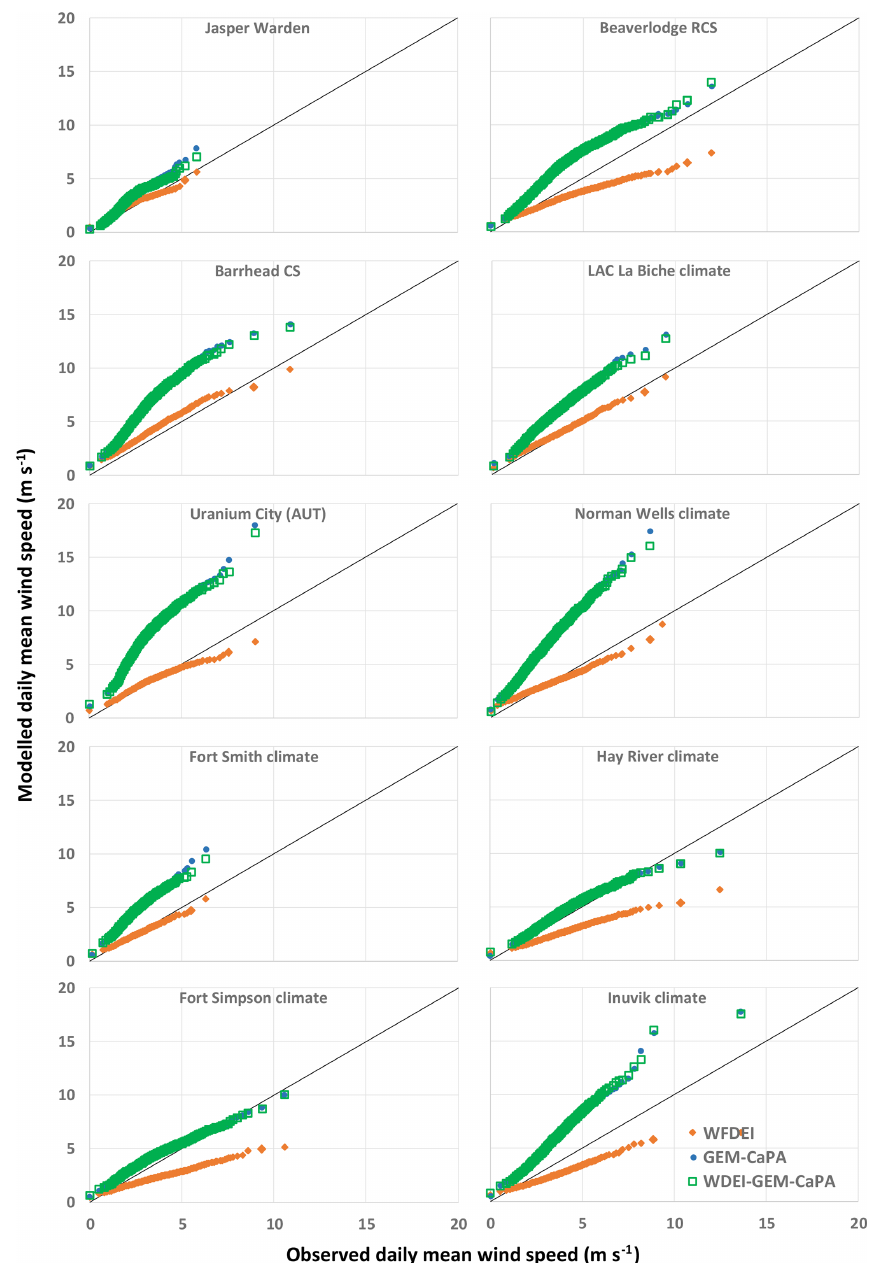
Figure 9. Quantile–quantile plots of modelled (GEM-CaPA, WFDEI, and WFDEI-GEM-CaPA) and observed daily mean wind speed.